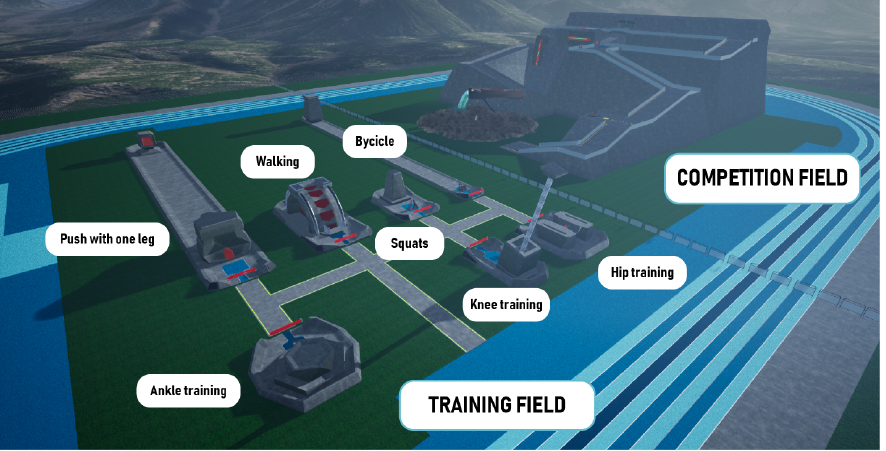
Figure 6. Training and Competition field.